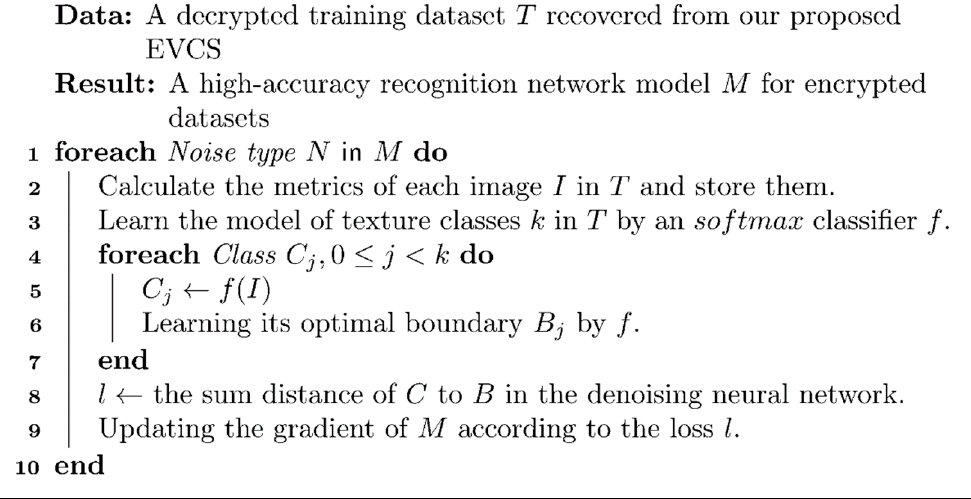
pairs (cid:4668)𝑥 (cid:3036) , 𝑦 (cid:3036) (cid:4669) , where 𝑥 (cid:3036) ∈ 𝑋, 𝑦 (cid:3036) ∈ 𝑌 and the objective function 𝑓 should be learned from the